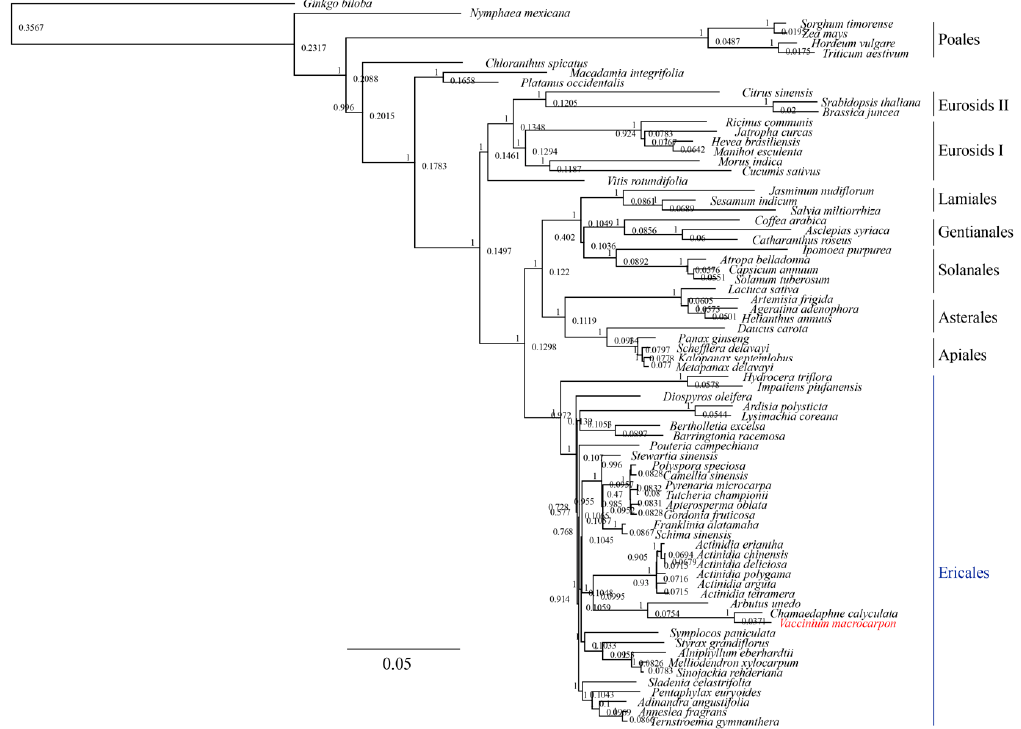
Figure 3. Phylogenetic relationship of V. macrocarpon (and Alaskan V. microcarpum ) with related species based on 68 protein-coding genes shared by all the plastid genomes. Tree constructed in FastTree using the generalized time-reversible (GTR) model. Branch labels correspond to the FastTree support values, whereas node labels show node heights. Ginkgo biloba was used as the outgroup.